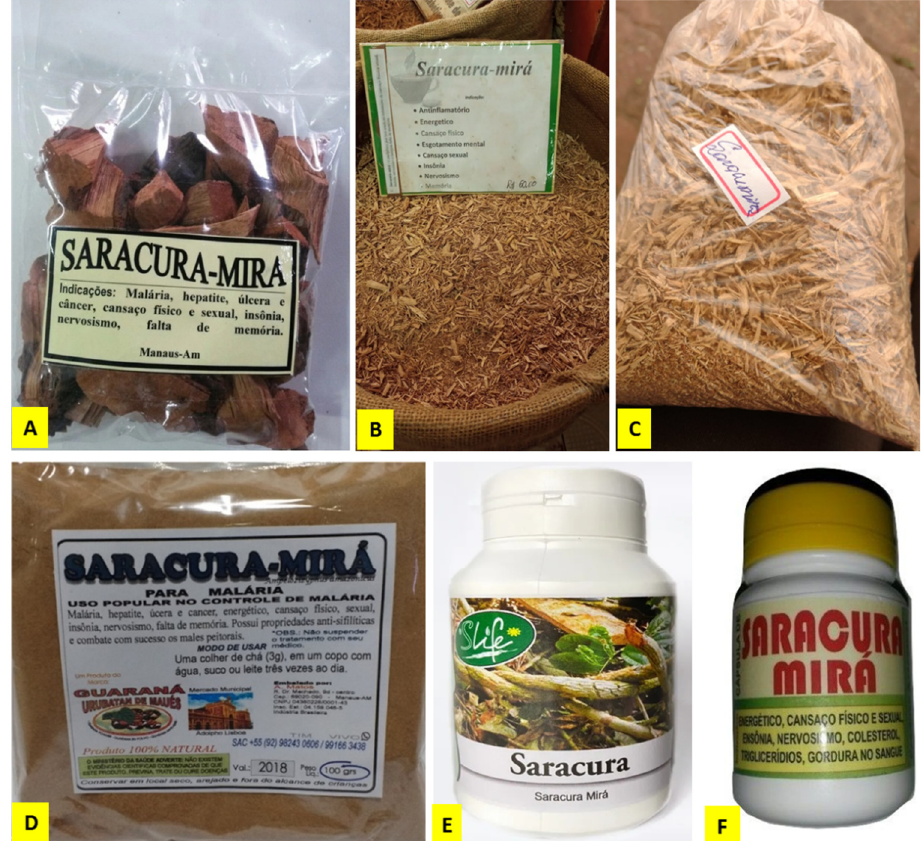
Figure 3. Commercial samples of “saracura-mirá” sold in open markets in northern cities of Brazil and on some internet websites. ( A ) Stem bark sold in pieces; ( B , C ) stem bark comminuted in small fragments with part of the wood sold at the Ver-O-Peso Market, Belém, Pará State, Brazil; ( D ) powdered bark; ( E , F ) irregular products (unregistered at the Brazilian National Health Surveillance Agency, ANVISA) sold as capsules (source: https://produto.mercadolivre.com.br/MLB-1909499730-saracura-kit-12-frascos-100-natural-60-capsulas-de-500mg-, accessed 31 October 2021).